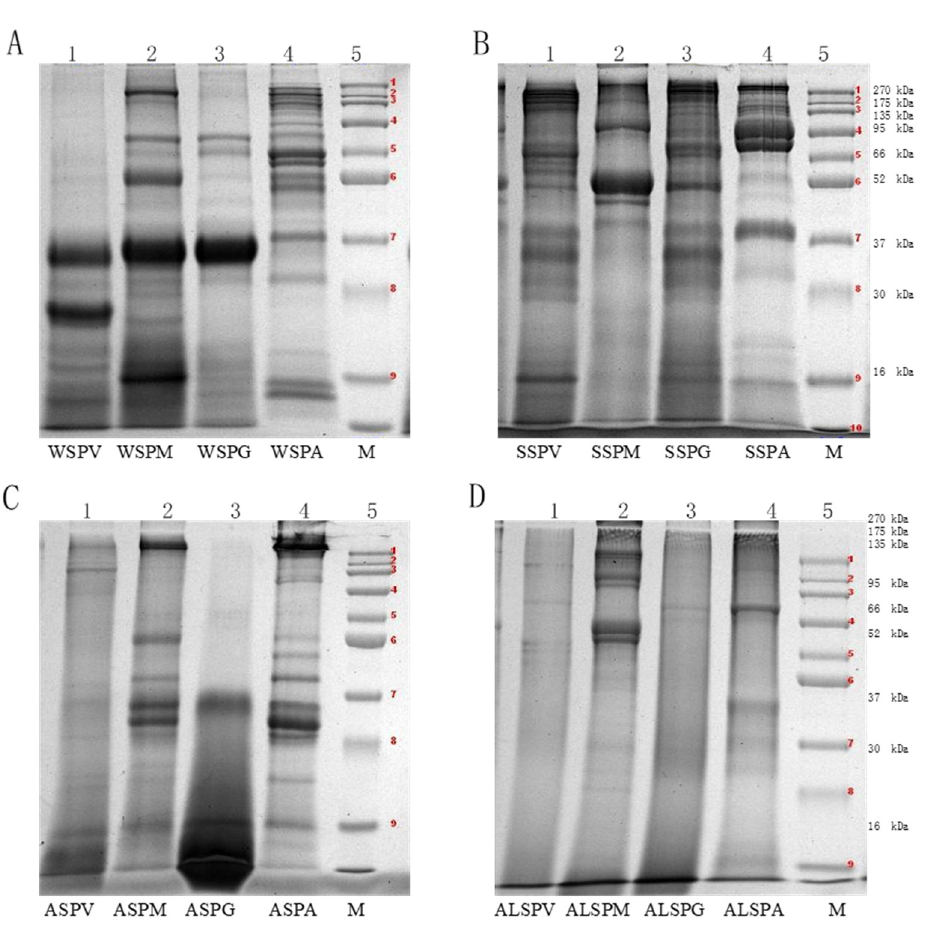
Figure 2. Molecular mass distribution of proteins isolated from different parts of oyster ( Crassostrea hongkongensis ). ( A ), Electrophoregrams of the WSP components in visceral mass, mantle, gill and